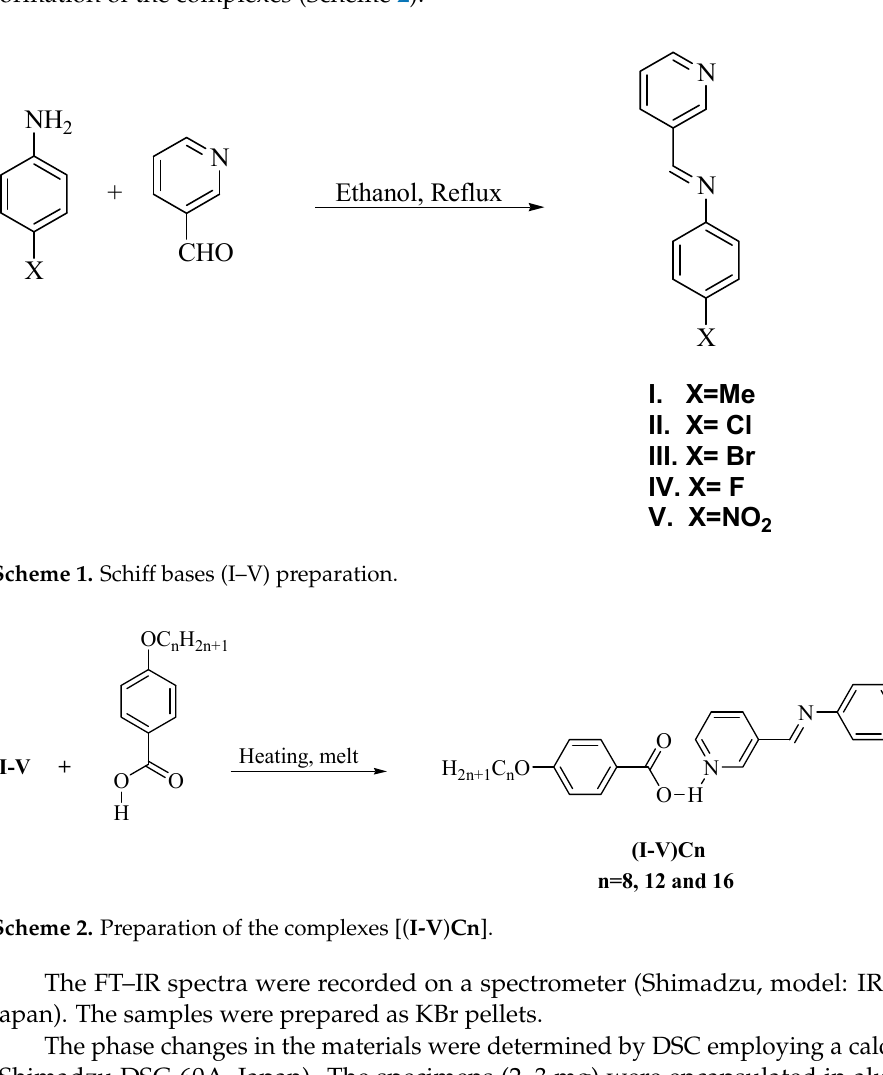
Figure 9. Molecular electrostatic potentials (MEP) for the para-octyloxy benzoic acid C8 supramolecular complexes pre- pared, ( I-V ) C8 , H (gray), C (black), N (blue) and O (red).